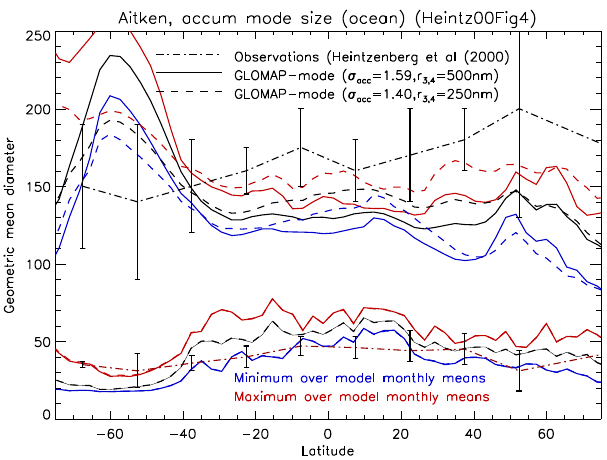
Fig. 3. Simulated marine surface zonal-mean geometric mean particle diameters in the Aitken and accumulation mode com- pared to observed values from a compilation of 30-yr of mea- sured size distribution data (asterisks) for the marine boundary layer (Heintzenberg et al., 2000). The black lines show simulated annual mean (averaged to the 15-degree grid) and the blue/red lines show minimum/maximum monthly-mean values. Results from two GLOMAP-mode v6 runs are shown: as configured originally (solid lines) and after the revisions to the modal aerosol settings (dashed lines). The error-bars around the asterisks show the ob- served standard-deviation in each latitude band. Values of nor- malised mean bias and correlation coefficient are shown in Table 5 from model annual-means (ocean grid boxes only) and by averaging up to the 15 degree grid to match the observations.